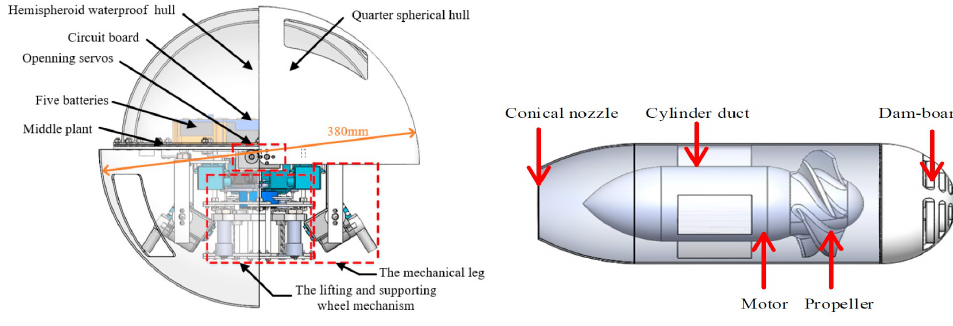
Figure 1. The overall structural design and the improved motor jet of the underwater spherical robot platform